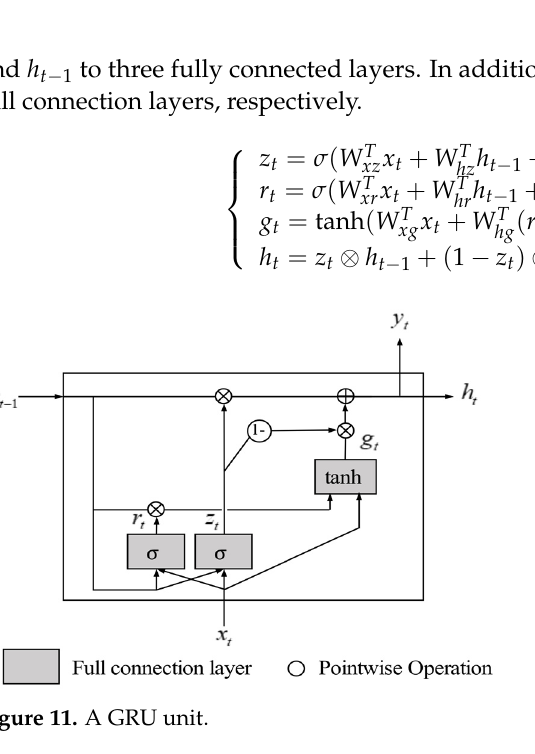
TS i m , and TS i m ) are firstly filled with a value v to the same length. After going through 2 3 the mask layer, the network will ignore the time step in which the data are filled with v.